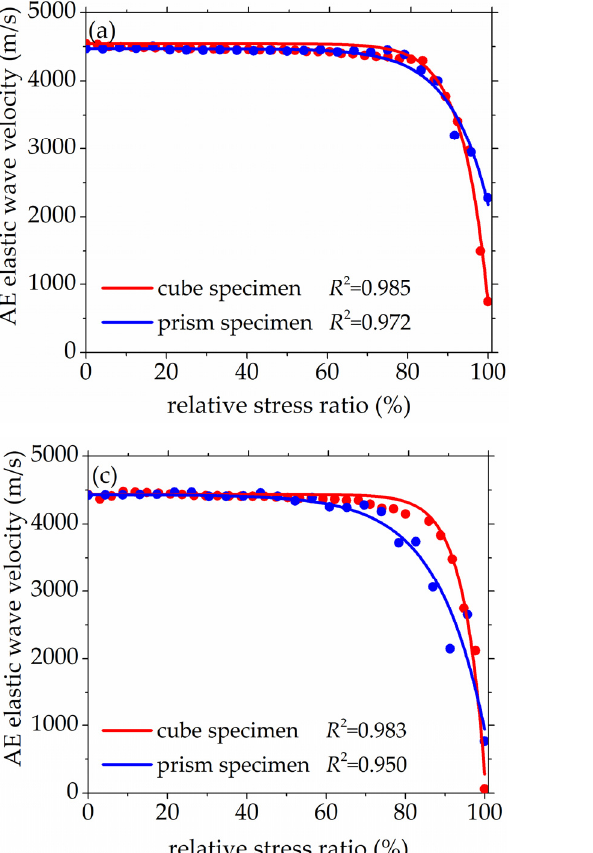
Figure 7. The relationship between AE elastic wave velocity and relative stress ratio with different maximum sizes of coarse aggregate, ( a ) 9.5 mm, ( b ) 19 mm, ( c ) 26.5 mm, ( d ) 31.5 mm.